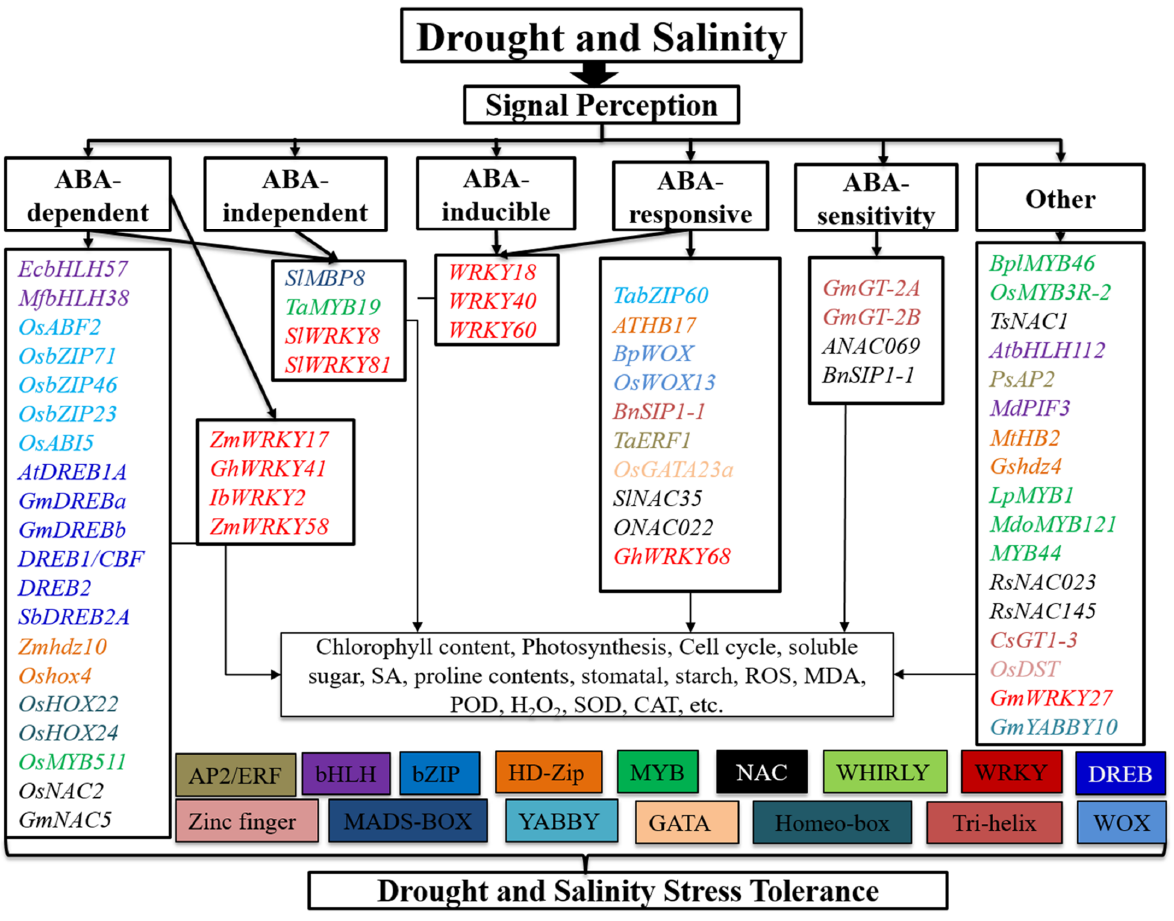
Figure 4. Genes and signaling pathways that regulate drought and salinity stress tolerance. These pathways include the AP2/ERF, bHLH, bZIP, DREB, HD-Zip, Homeo-box, MADS-box, MYB, NAC, Tri-helix, WOX, WHIRLY, WRKY, YABBY, and zinc finger. These regulators control drought and salinity stress tolerance through ABA-dependent, -independent, -responsive, -inducible, and -sensitivity pathways, among others, which play an essential role in photosynthesis, the cell cycle, stomatal development, and ROS, chlorophyll, MDA, POD, SOD, CAT, starch, and proline content. Different text colors represent different transcription factors. 2.9. MYB Arabidopsis AtMYB60 is an R2R3-MYB gene expressed in guard cells that is nega- tively modulated during drought and involved in regulating stomatal movements. The mutant with a T-DNA insertion of ATMYB60 showed a reduction in the stomatal opening, and the mutation’s effects on water loss and transpiration rate during drought stress [86]. Constructive expression of the rice cold-inducible OsMYB4 gene in transgenic Arabidop- sis plants increased under drought and cold stress and was likely due to the constitutive activation of several stress-inducible pathways. OsMYB4 gene expression enhanced the stress response in apples [87]. The GmMYB84 TF from soybean, induced by drought, salt, and ABA, plays a crucial role in ROS homeostasis and control of the abiotic stress response in plants [88]. GmMYB84 overexpression in soybean enhanced drought stress resistance by increasing the ROS and antioxidant enzyme content, including SOD, POD, and CAT. Moreover, overexpression led to improved primary growth, high survival rates, and reduced dehydration under drought stress [88]. OSMYB55 overexpression in maize shows increased plant biomass and reduced leaf damage caused by high-temperature exposure,